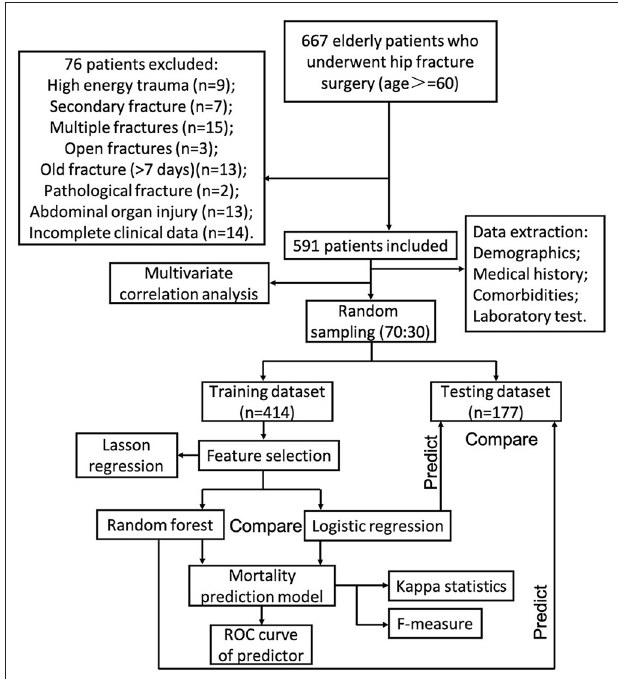
FIGURE 1 | The procedure of establishing mortality prediction models in this